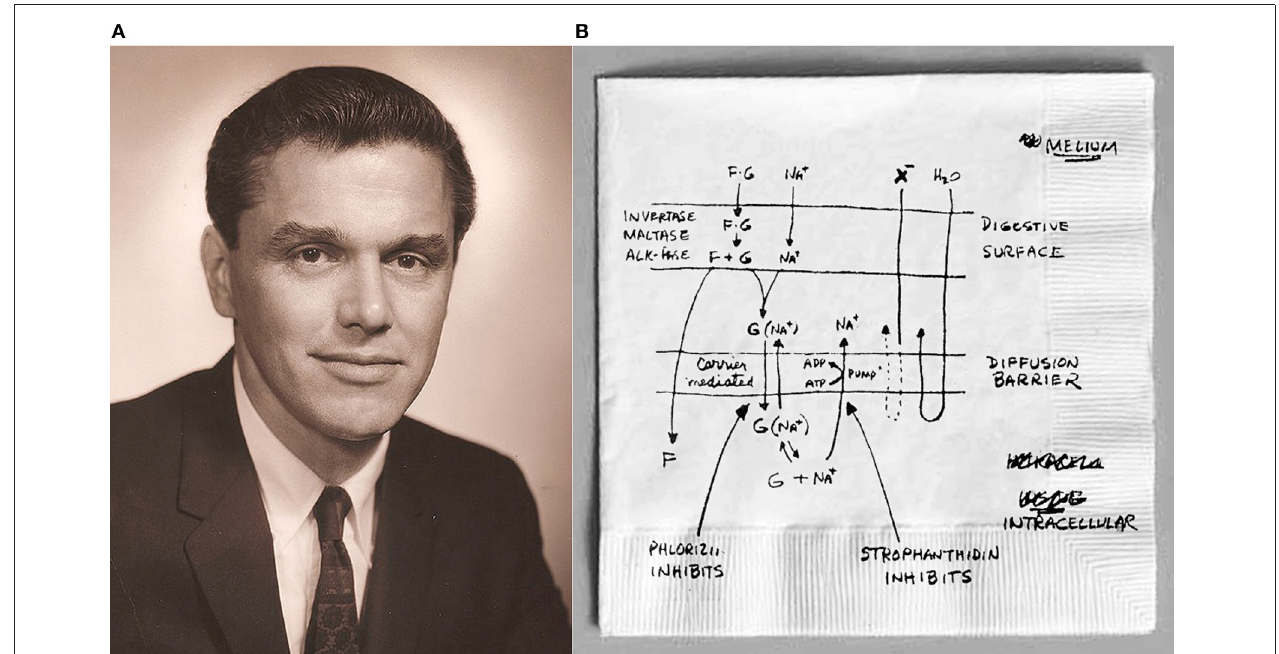
that was first shown at the meetings in Prague in 1960. (Photo of Crane used with permission the Creative Commons Attribution 3.0 United States (http://creativecommons.org/licenses/by/3.0/us/deed.en) license) (Photo of the Na + -glucose cotransport model from “For Living History” from the American Physiological Society website http://the-aps.org/mm/Membership/